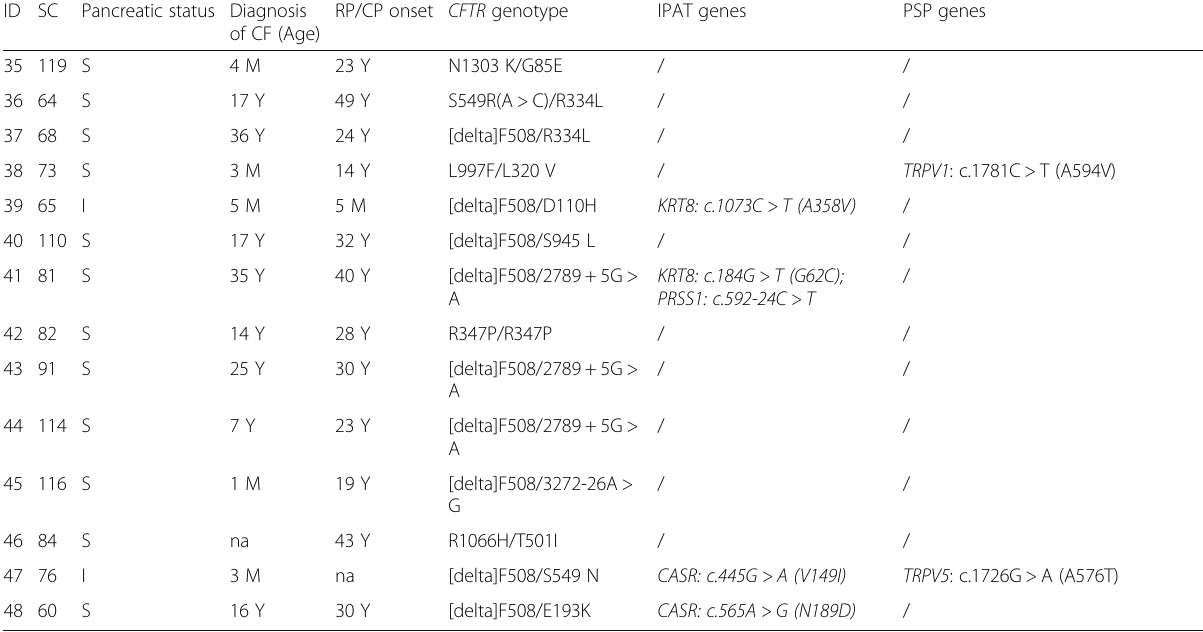
Table 2 Sweat chloride (mmol/L, SC), pancreatic status, age at CF and pancreatitis diagnosis, CFTR genotype and mutations in genes related to intra-pancreatic activation of trypsin (IPAT) and pancreatic secretion pathway (PSP) genes in 48 patients with CF and recurrent/chronic pancreatitis (Continued)